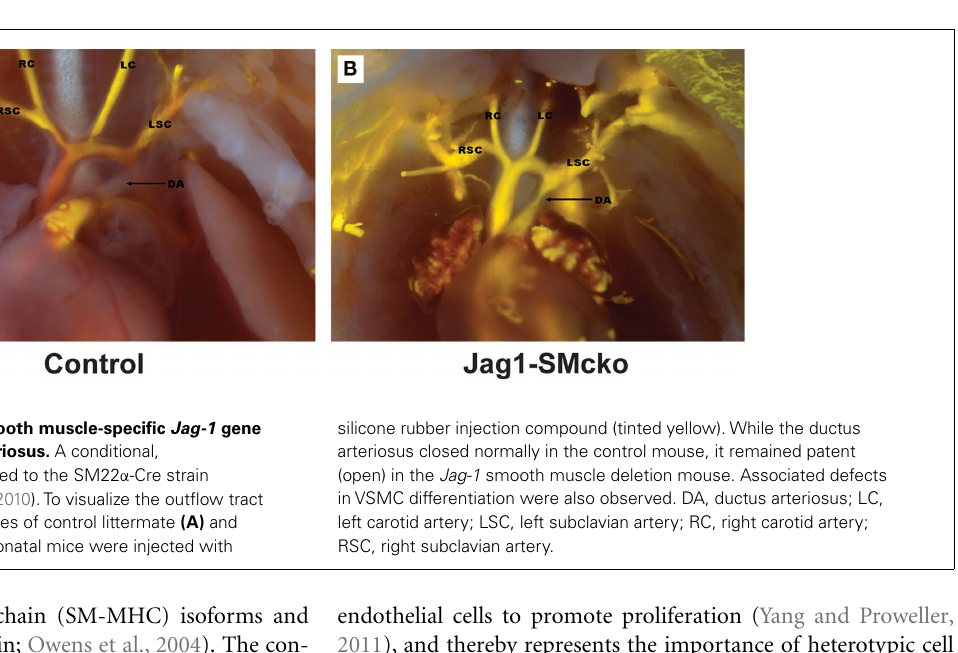
FIGURE 2 | Neonatal mice with smooth muscle-specific Jag-1 gene deletion exhibit patent ductus arteriosus. A conditional, Cre-responsive Jag-1 allele was crossed to the SM22 α -Cre strain (TagIn-Cre) as described (Feng et al., 2010).To visualize the outflow tract and ductus arteriosus, the left ventricles of control littermate (A) and Jag-1 smooth muscle deletion (B) neonatal mice were injected with